Question: Sum up the contents of this chart in one sentence.
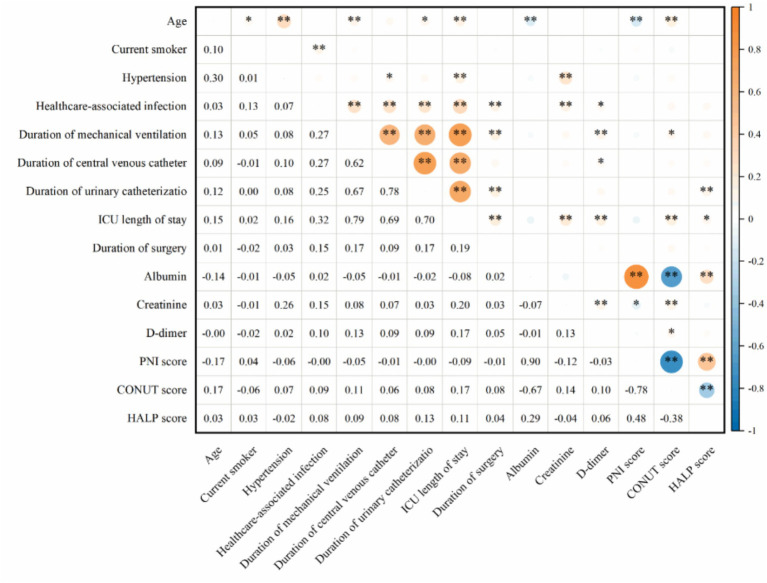
Answer: Correlation matrix between clinical parameters and nutritional indicators in patients with IE.